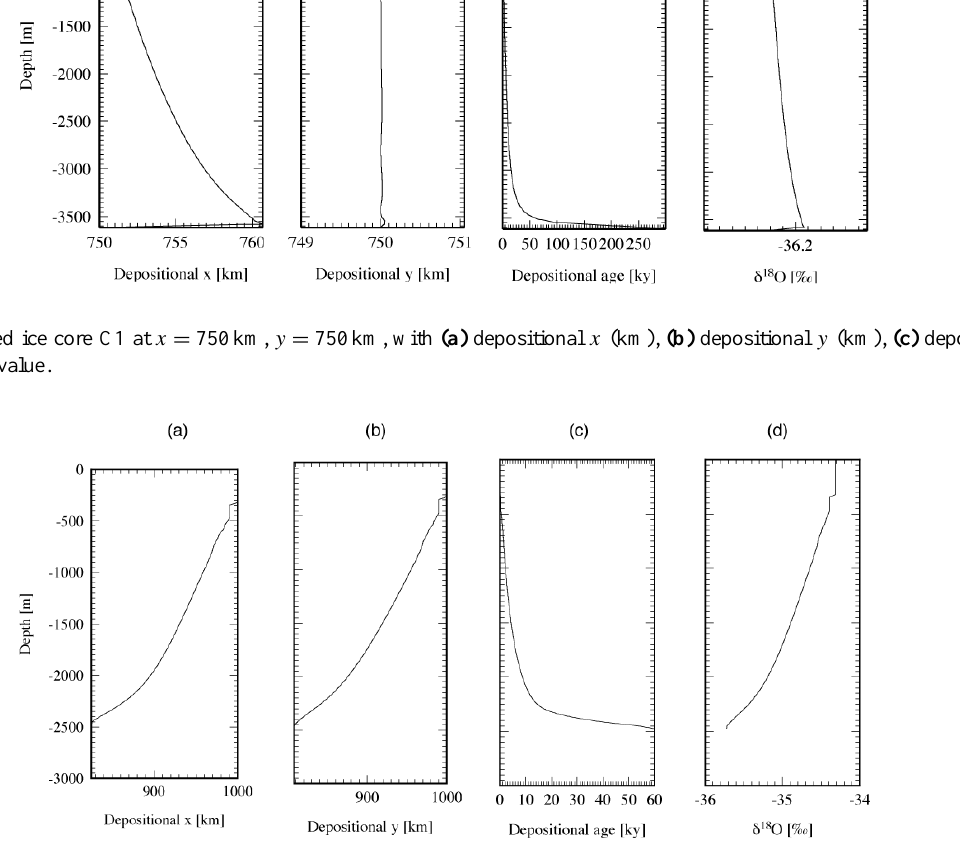
Figure 12. Simulated ice core C2 at x = 1000km, y = 1000km, same arrangement as in Fig.